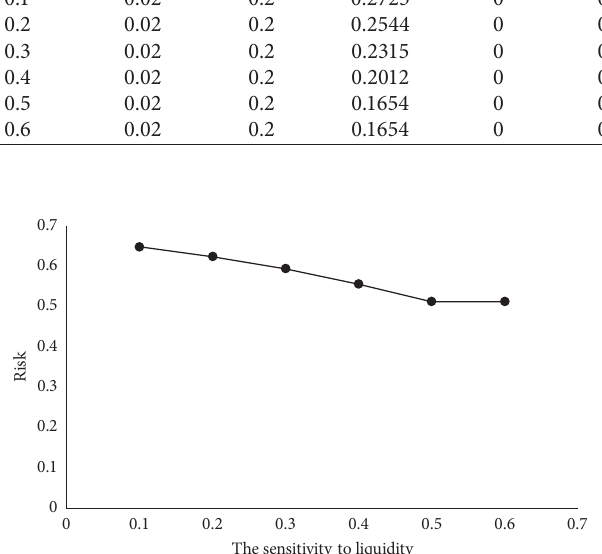
Figure 4: Variation of portfolio risk with investor sensitivity α .